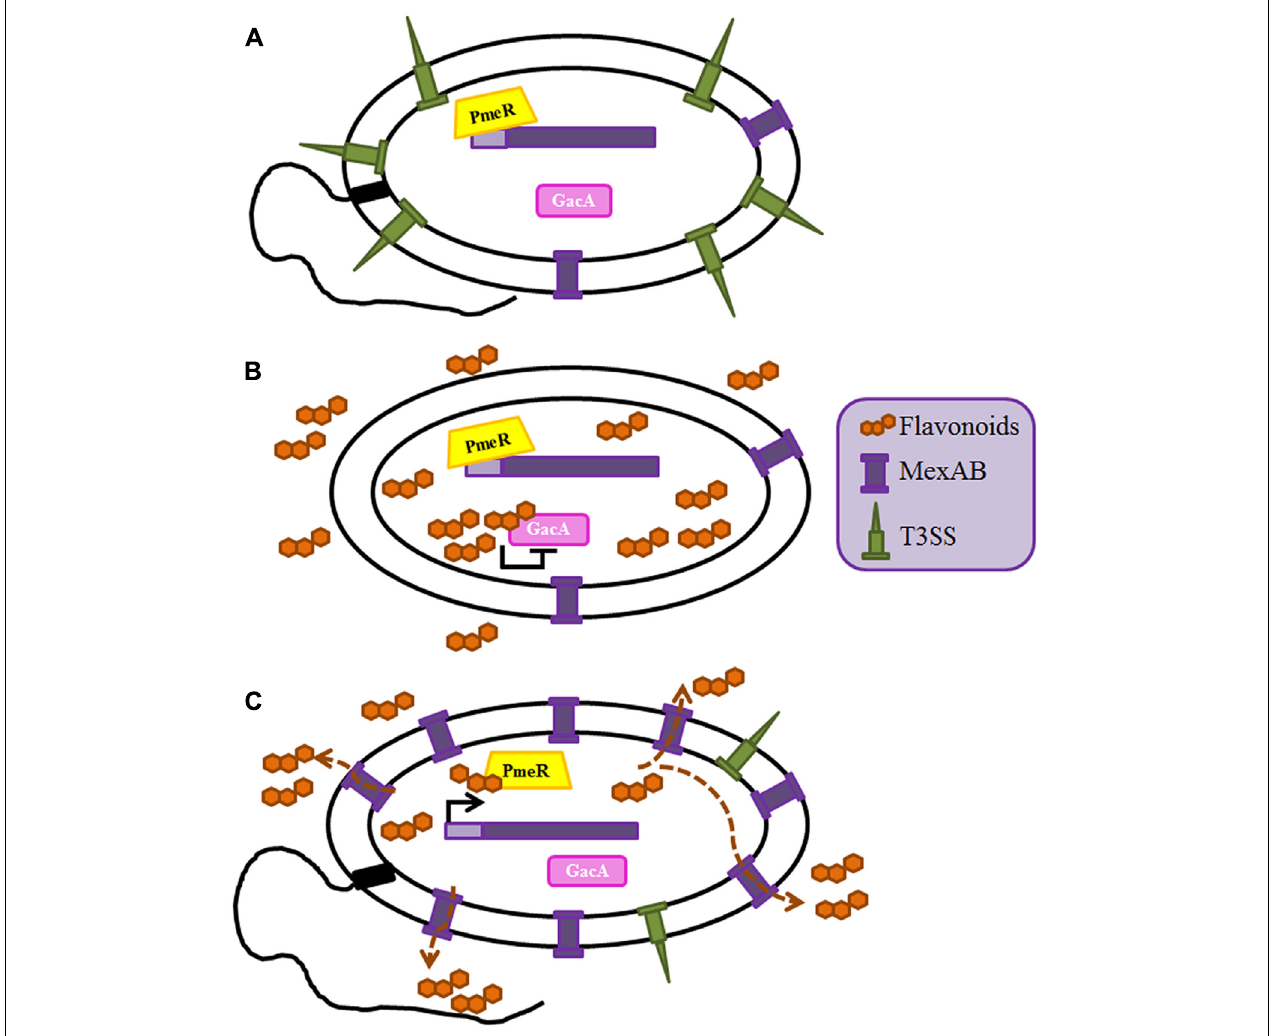
FIGURE 2 | Role of the MexAB-OprM efflux pump in the adaptive co-evolution of plant defense and P. syringae virulence. The intracellular amount of the plant flavonoids is regulated by MexAB-OprM efflux pump. (A) Expression of mexAB-oprM is controlled by the transcriptional repressor PmeR; in the absence of flavonoids the expression of this efflux pump is repressed and expression of virulence determinants as the T3SS or bacterial motility is activated through the GacS/A TCS (Vargas et al., 2011). (B) The presence of flavonoids inhibits GacS/A, hence leading a transient low virulence phenotype, in which the expression of the T3SS and the motility are low (Vargas et al., 2013). (C) The accumulation of flavonoids inside the cell leads to over-expression of mexAB-oprM through the release of its transcriptional regulator PmeR from its operator. Since flavonoids are substrates of MexAB-OprM, under these conditions they are efficiently extruded and their intracellular concentration falls down below the threshold required for inactivating GacS/GacA. As a consequence of this situation, the virulent state of P. syringae is